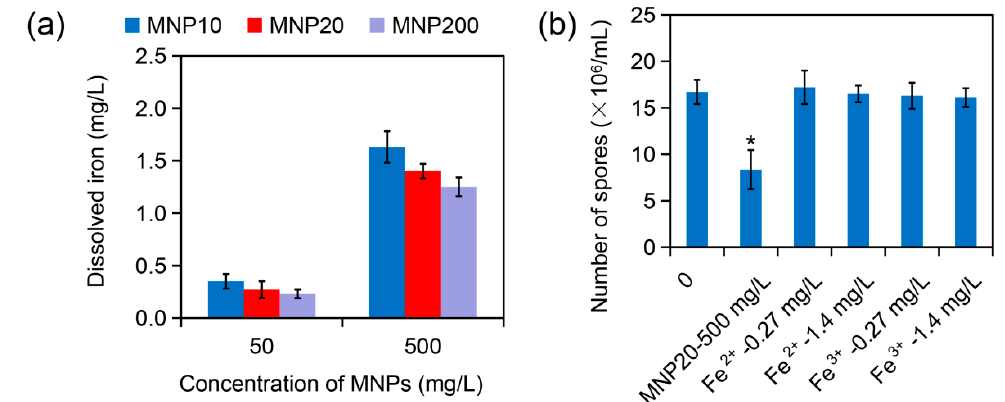
Figure 4. Iron dissolution from the MNPs and its effect on sporulation A. niger under MNP treatment. ( a ) Iron dissolution from the MNPs at the concentration of 50 mg/L or 500 mg/L in liquid PDA medium. ( b ) Effect of ferrous ion (Fe 2+ ) and ferric ion (Fe 3+ ) on sporulation of A. niger . The asterisks (*) indicate a significant difference between the MNP20 group and other groups ( p < 0.05).